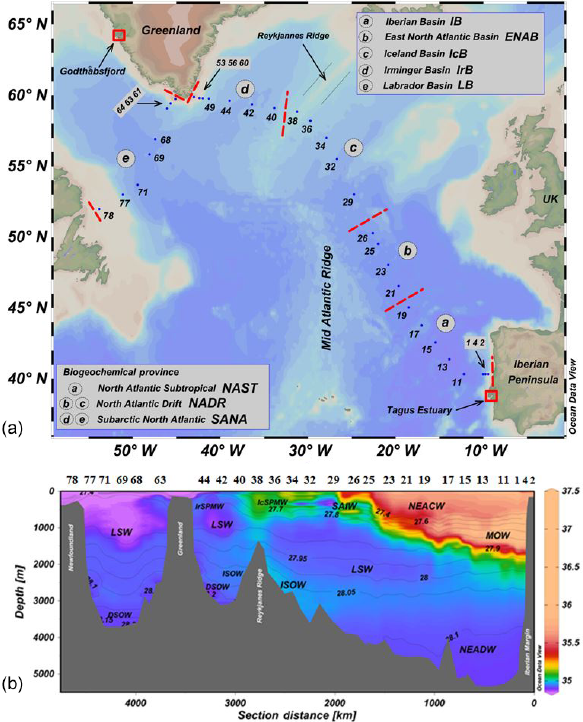
Figure 1. (a) The cruise track along the North Atlantic and the Labrador Sea. (b) Cross-section plot of salinity along GEOVIDE. Annotations represent main water masses in the study region. Iso- lines represent layers of equal neutral density ( y n ). DSOW, Den- mark Strait Overflow Water; ISOW, Iceland Scotland Overflow Wa- ter; LSW, Labrador Sea Water; MOW, Mediterranean Outflow Wa- ter; NEACW, North East Atlantic Central Water; NEADW, North East Atlantic Deep Water; IcSPMW, Iceland Sub-Polar Mode Wa- ter; IrSPMW, Irminger Sub-Polar Mode Water; SAIW, Sub-Arctic Intermediate Water. Plots created in Ocean Data View (Schlitzer,